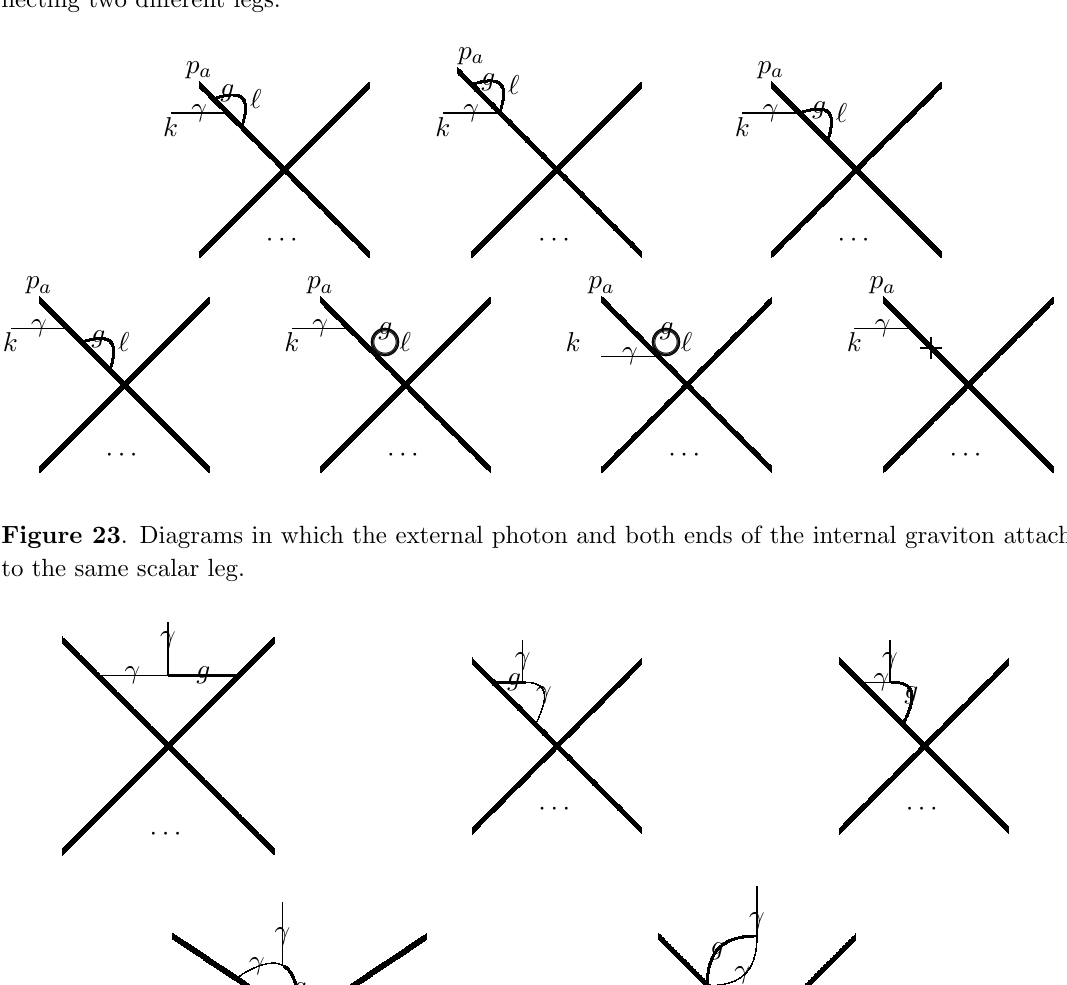
Figure 22 . One loop contribution to soft photon amplitude involving internal graviton line con- necting two di(cid:11)erent legs.